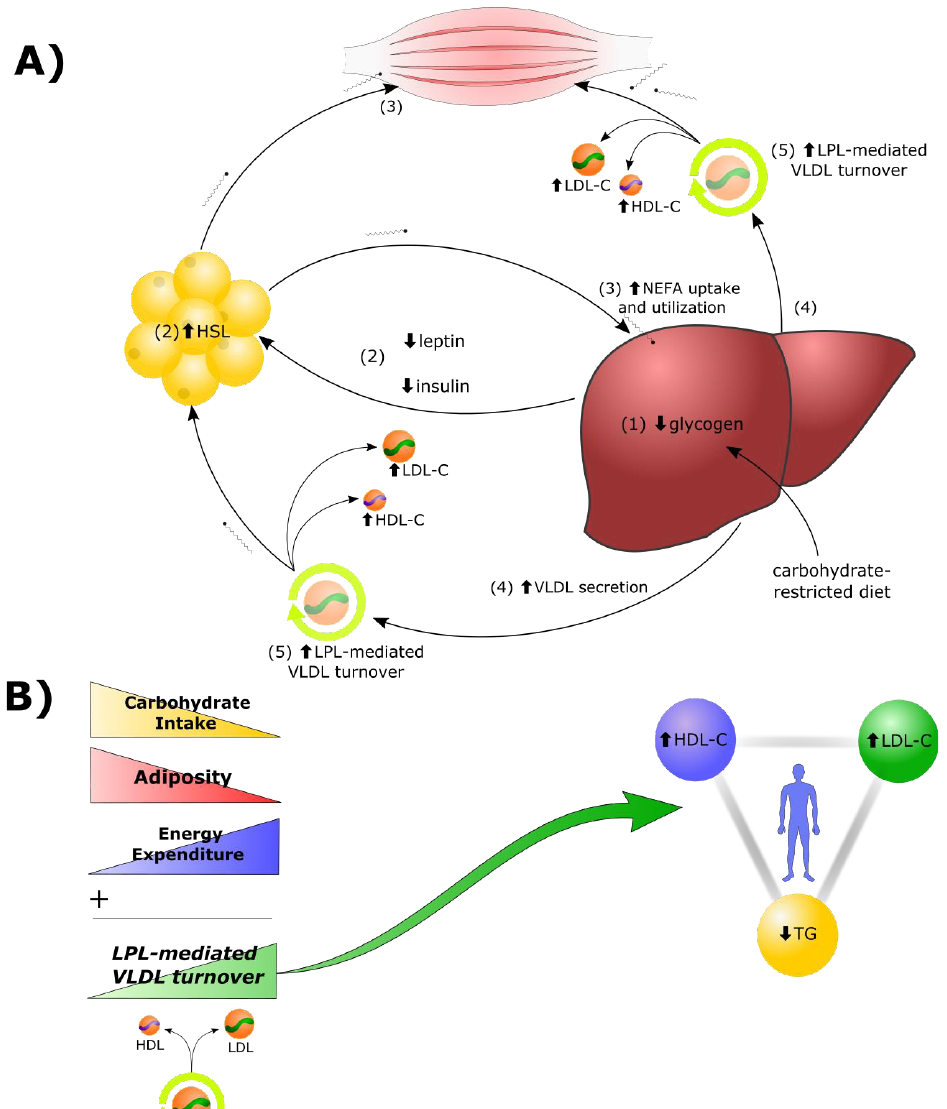
Figure 1. The Lipid Energy Model . ( A ) In the context of carbohydrate restriction, (1) glycogen depletion and (2) changes in circulating hormones stimulate hormone-sensitive lipase (HSL)-mediated secretion of non-esterified fatty acids (NEFA) by adipocytes to fuel oxidative tissues. (3) The liver captures circulating NEFAs and repackages them into triglycerides (TG), (4) secreted aboard VLDL. (5) Increased lipoprotein-lipase (LPL)-mediated VLDL turnover generates increased LDL-C and HDL-C. (Further details can be found in the main text.) The role of chylomicrons in the post-prandial state is presented later in the text. ( B ) The magnitude of carbohydrate restriction, adiposity, and energy expenditure each contribute, as independent variables, to the degree of LPL-mediated VLDL turnover and, thereby, to the magnitude of change of the triad components.